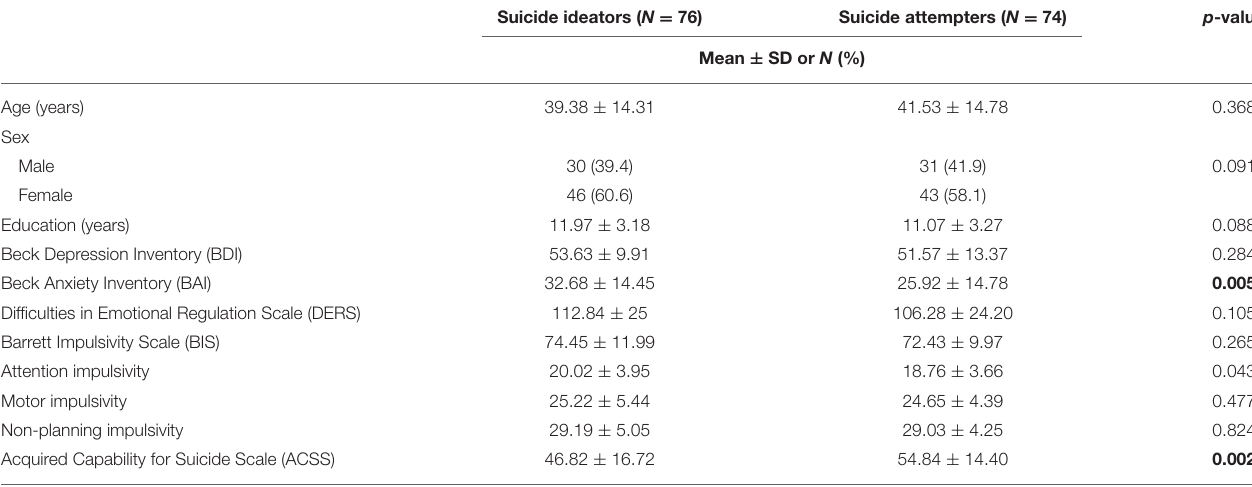
TABLE 1 | Comparison of baseline demographic and clinical symptom characteristics between suicide ideators and suicide